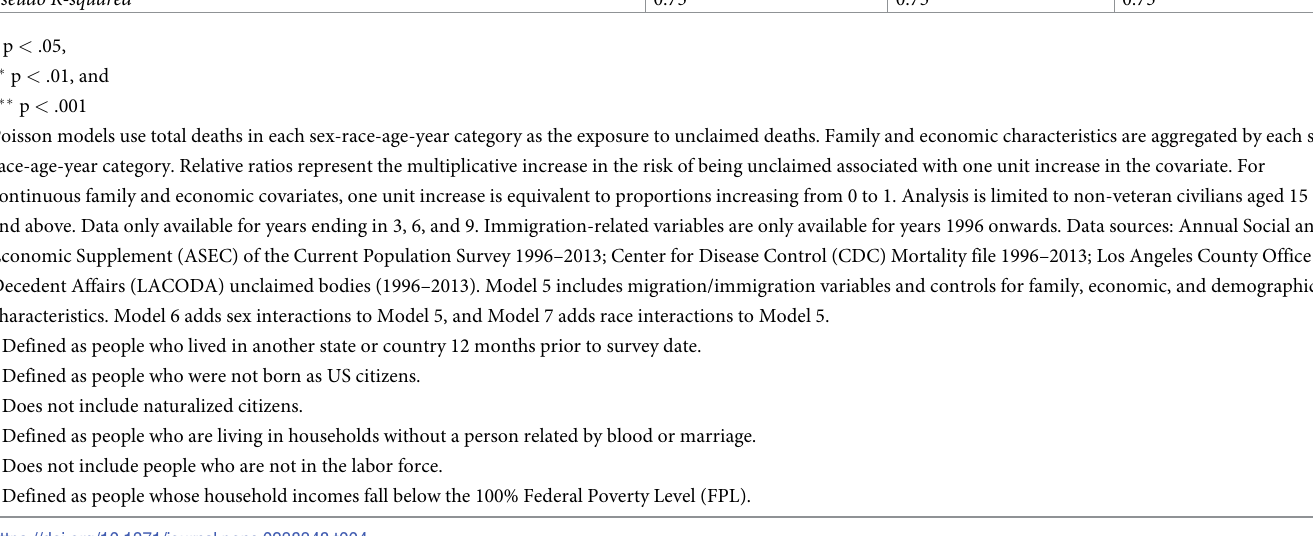
The final set of results (Table 5) estimates the relative rates of being reclaimed by kin within three years. Model 8 shows that male remains have significantly lower reclaimed rates than female remains (0.855), and African American remains are about half as likely to be reclaimed than white remains. Models 9 to 11 show a limited association between family isolation, eco- nomic hardship, and long-distance migration to rates of unclaimed bodies being